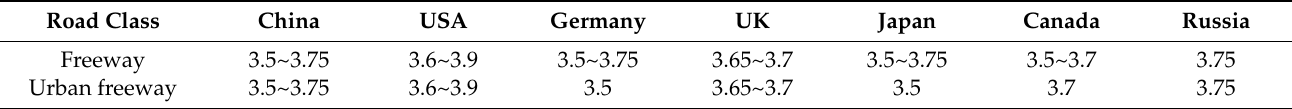
Table 1. The specified of lane width of freeway in some countries (unit: